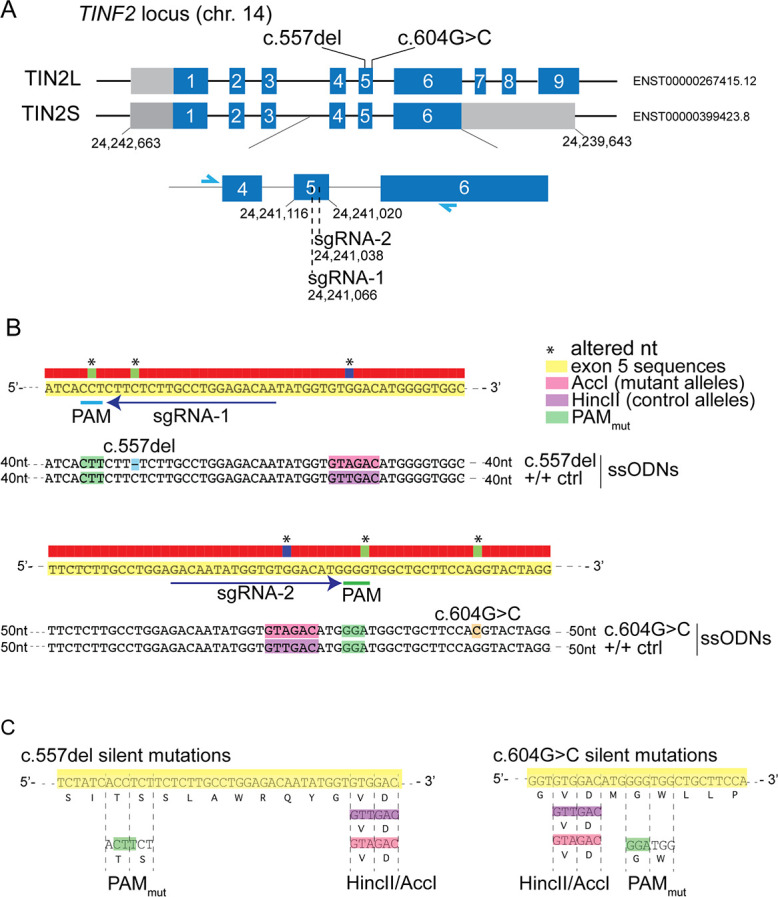
Knock-in strategy for introduction of c.557del and c.604G > C mutations into RPE1 cells.(A) Schematic of the TINF2 locus showing landmarks relevant to CRISPR/Cas9-mediated knock-in of TINF2 mutations. The single guide RNA (sgRNA) target regions and the primers used for genotyping (blue arrows) are indicated. (B) Schematic showing the reference sequence (yellow), the PAM (green), sgRNA sequences, and mutant and control (with silent mutations) repair templates that were co-transfected with the sgRNA/Cas9 vector. The upper panel shows the repair template used to introduce c.557del mutations and the lower panel the template used for c.604G > C. Repair templates were designed to introduce the respective mutations, mutate the PAM sequence (green) and introduce restriction sites for screening (pink and purple). (C) Schematic showing that the introduced PAM mutations and added restriction sites do not change the amino acid sequence.